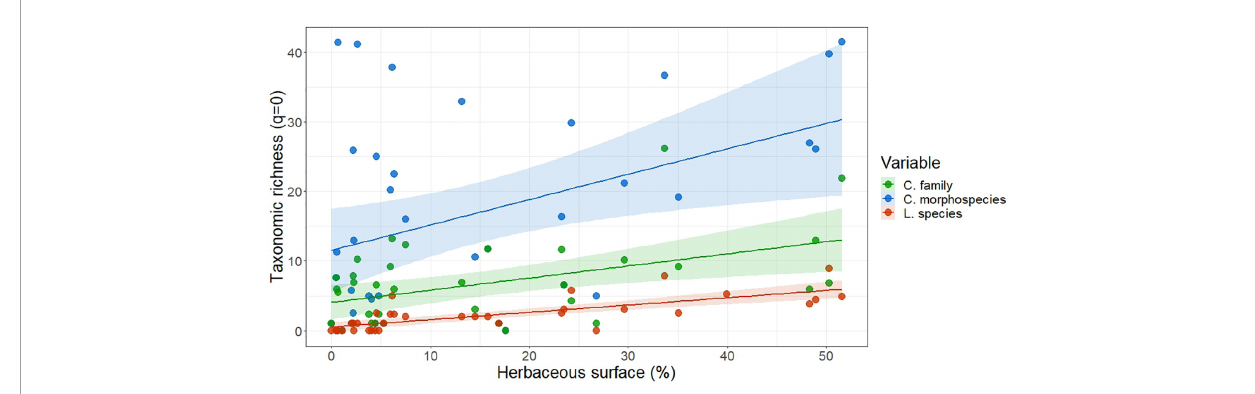
FIGURE4 Association between the taxonomic (families and species)/morphological (morphospecies) richness ( q = 0) of the two studied groups (ground-dwelling Coleoptera and diurnal Lepidoptera) and the herbaceous coverage. Colored bands represent confidence